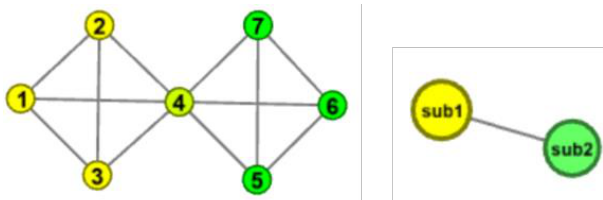
Figure 2. Example of Complete subgraph folding.